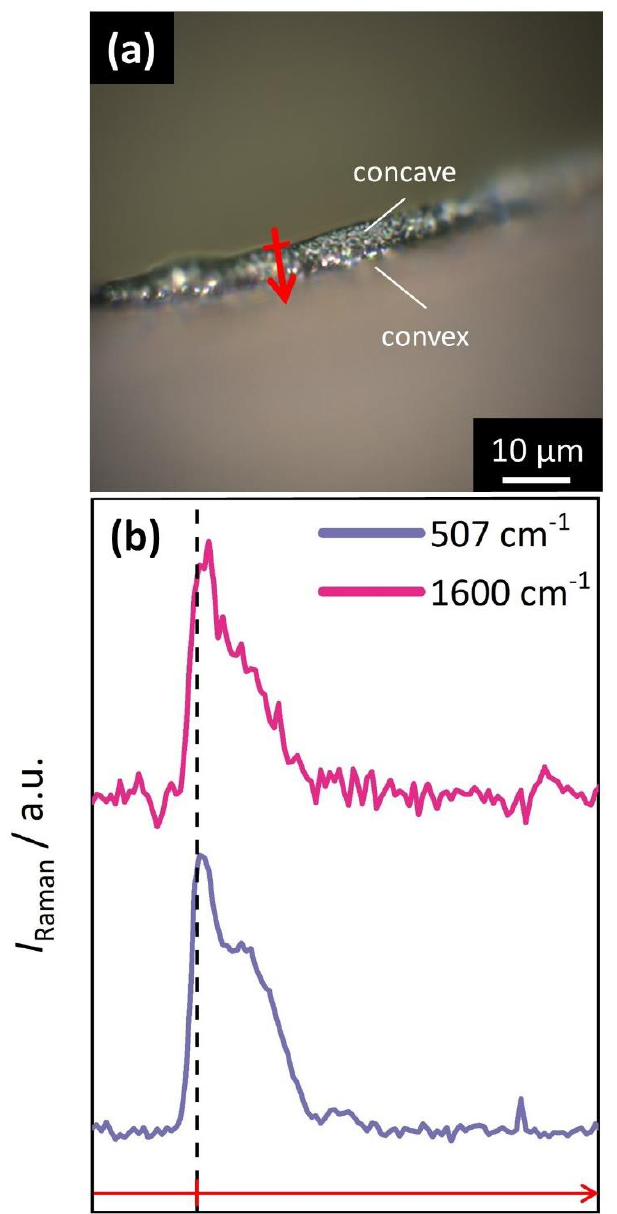
Figure 5. Confocal Raman microscopy line scan along the cross-section of an individual microscroll. ( a ) Optical microscopy view of the corresponding film cross-section. The red arrow marks the selected position and the direction of scanning. ( b ) Distribution profile of Raman intensity along the scanning direction plotted for signals corresponding to the mineral (507 cm − 1 , Co–O vibrations; purple) and the polymer phase (1600 cm − 1 , aromatic vibrations; pink). The dashed vertical line indicates the position of the concave surface of the microscroll with respect to the scanning direction. An overall intensity gradient of identical profile shape is visible for both signals, which suggests density differences between the concave and convex surface.